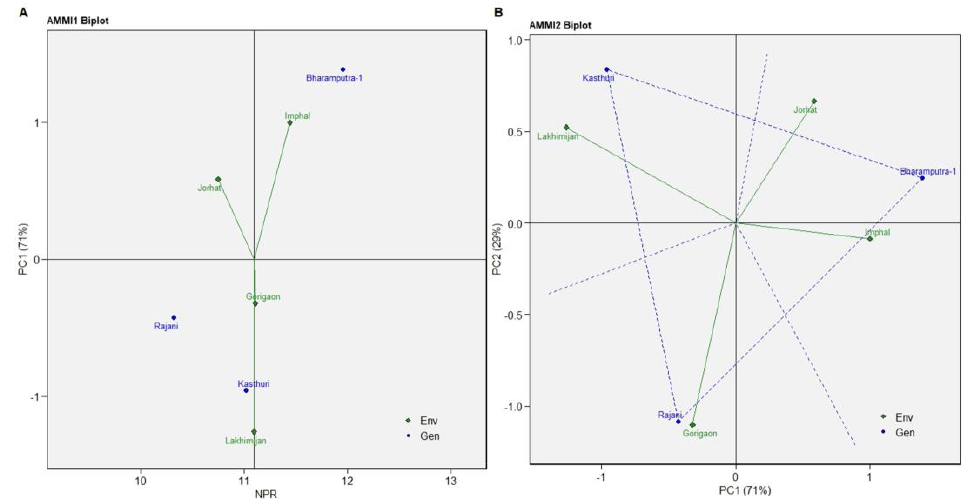
Figure 3. ( A ) AMMI1 biplot ( B ) AMMI2 biplot for number of primary rhizomes. Again, for NMR, the Rajani and Kasthuri varieties were more stable than Bharam- putra-1 (Figure 4A). The variety Kasthuri was best suitable for Imphal, Rajani variety for Lakhimijan, and Bharamputra-1 for Jorhat and Gorigaon, as revealed through AM- MI2 biplot analysis of NMR (Figure 4B). Figure 4. ( A ) AMMI1 biplot ( B ) AMMI2 biplot for number of mother rhizomes. The dry rhizome recovery of Bharamputra-1 was found to be less than those of Kasthuri and Rajani but showed stability in all MLTs (Figure 5A). As predicted in AM- MI2 biplot, DRR of Bharamputra-1 was highest in Jorhat while those of Rajani in Imphal and Gorigaon, and Kasthuri in Lakhimijan (Figure 5B).